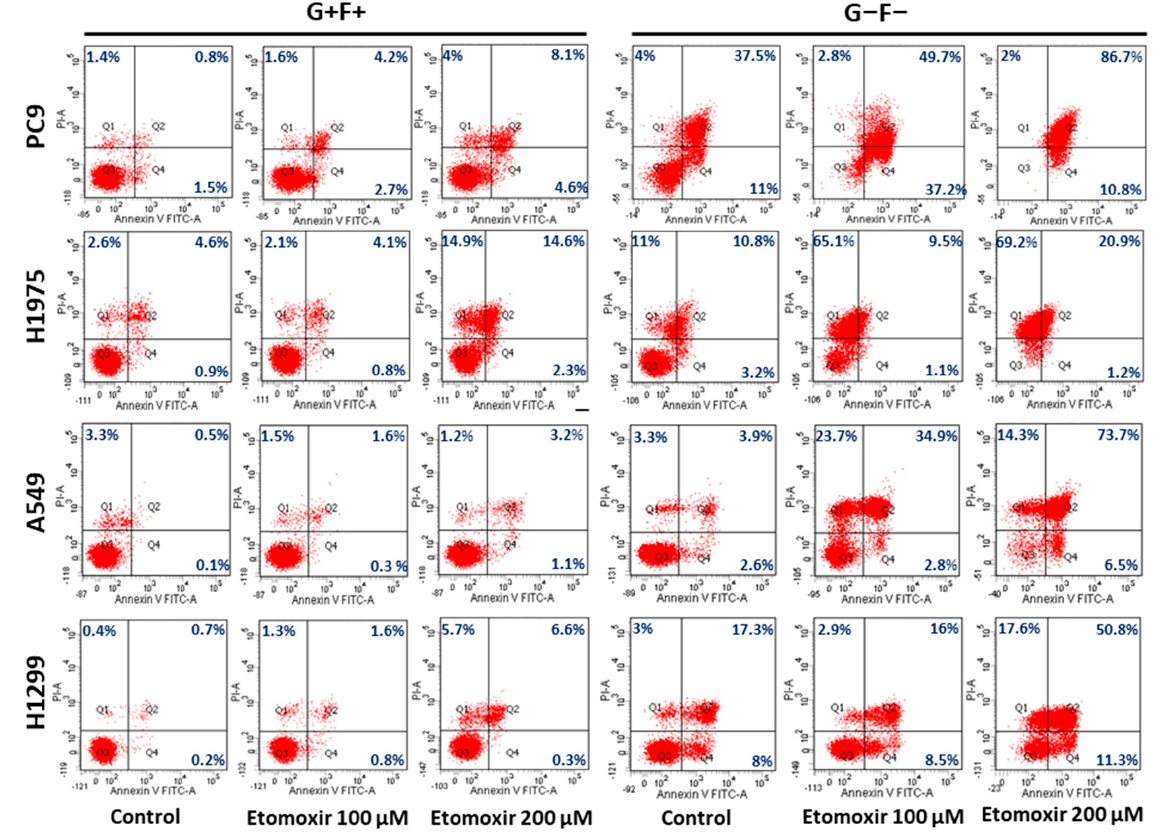
Figure 6. Lipids constitute an important energy source for lung cancer during starvation, and Etomoxir sensitizes lung cancer cells to starvation. Lung cancer cells are treated with Etomoxir either in normal growth medium (G+F+) or glucose- and serum-free medium (G − F − ) for 48 h. Cell death was measured by Annexin V/PI staining using flow cytometry.